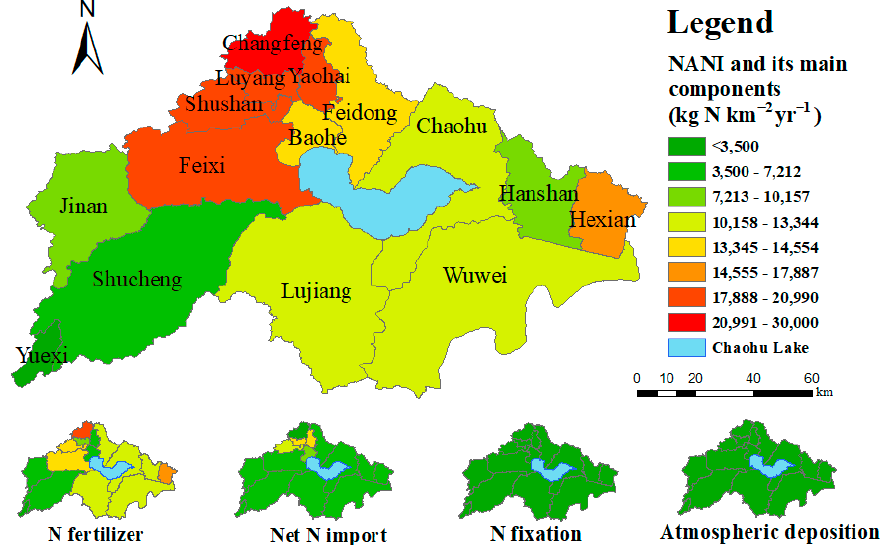
Figure 4. NANI model and its components (Net N imports, N fertilizer, N fixation, and atmospheric deposition) spatial pattern of county level from 1990 to 2018 (We use the average value of the NANI model and its components from 1990 to 2018 to show.).